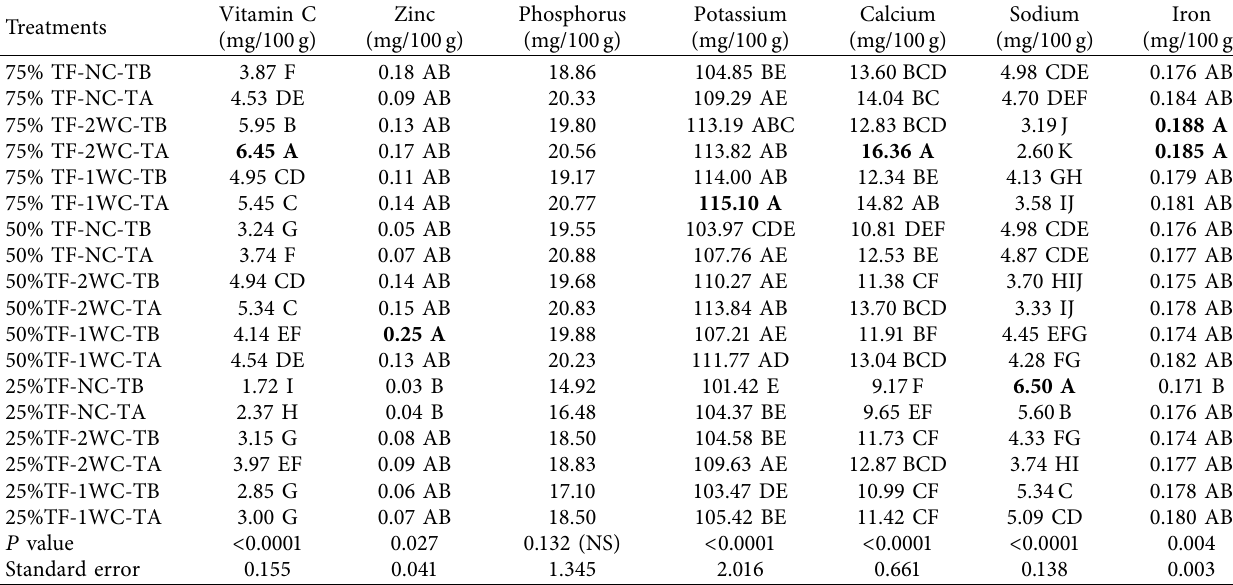
Table 5: Treatment effect on nutritional composition of stored bulb onions.